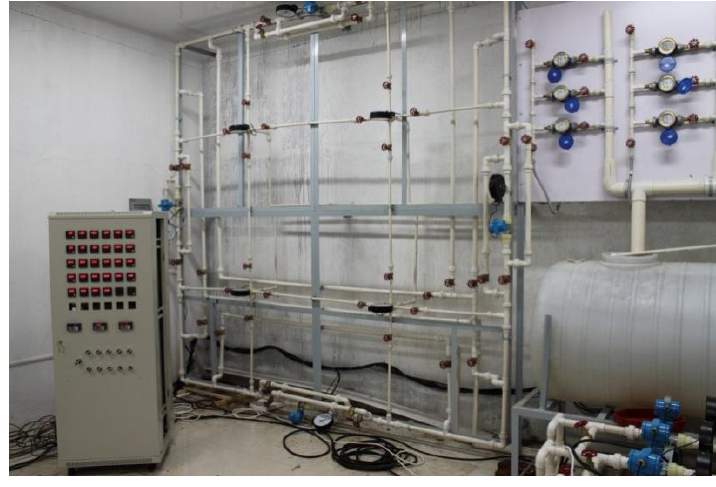
Fig. 2. Experimental platform of Leakage Separation of Water Supply Network